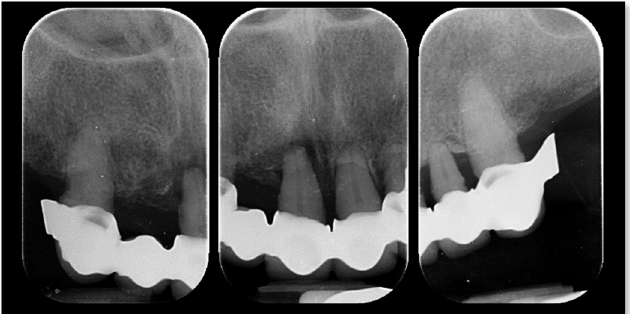
Figure 2. Preoperative periapical